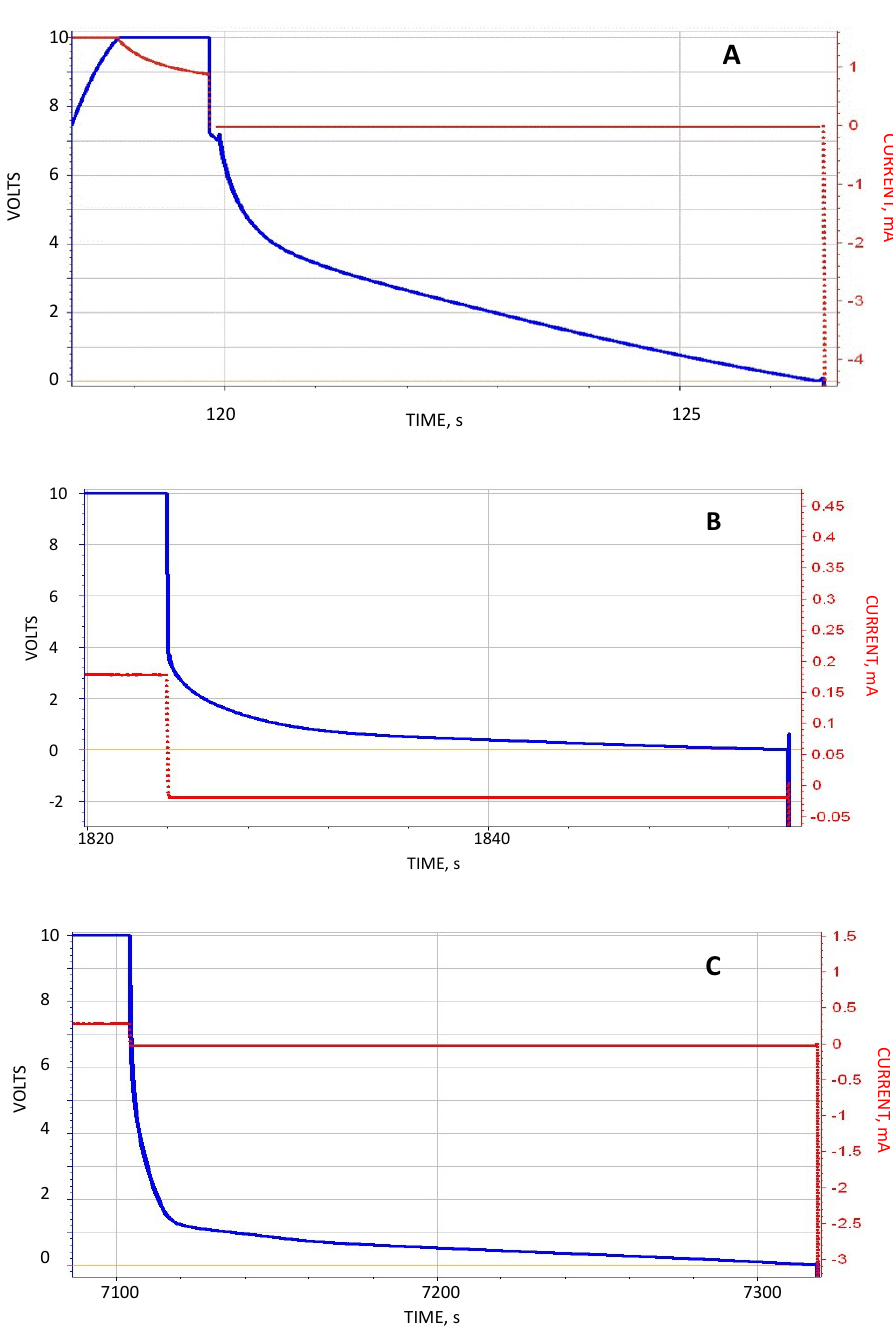
Figure 3. Impact of the hold time for dielectric, 0.5 wt % NaCl in deionized water (DI), only on the outside 20 mm capacitor. ( A ) Shown: Discharge, current 0.02 mA, following a hold time of 1 s at 10 V. The morphology of the discharge behavior for S-DOC (shown) and DI-DOC is very similar. ( B ) Shown: Discharge, current 0.02 mA, following a hold time of 200 s at 10 V. The discharge time (~30 s) was approximately 5× longer than that observed in (A). ( C ) Shown: Discharge, current 0.02 mA following a hold time of 600 s at 10 V. The discharge time (~210 s) was nearly 35× longer than that observed in (A).